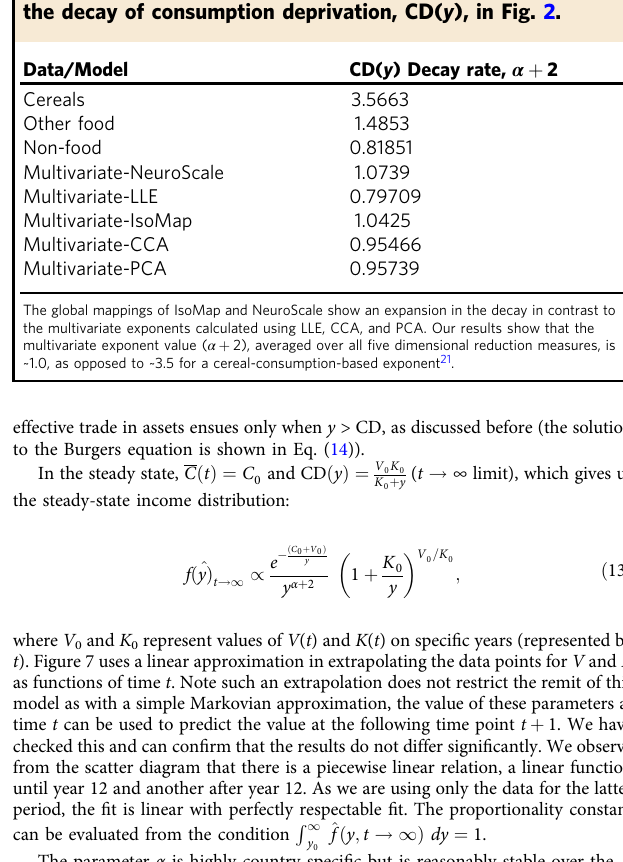
Table 1 Decay values, α , for each of the original data dimensions and the dimension reduced models governing the decay of consumption deprivation, CD( y ), in Fig.